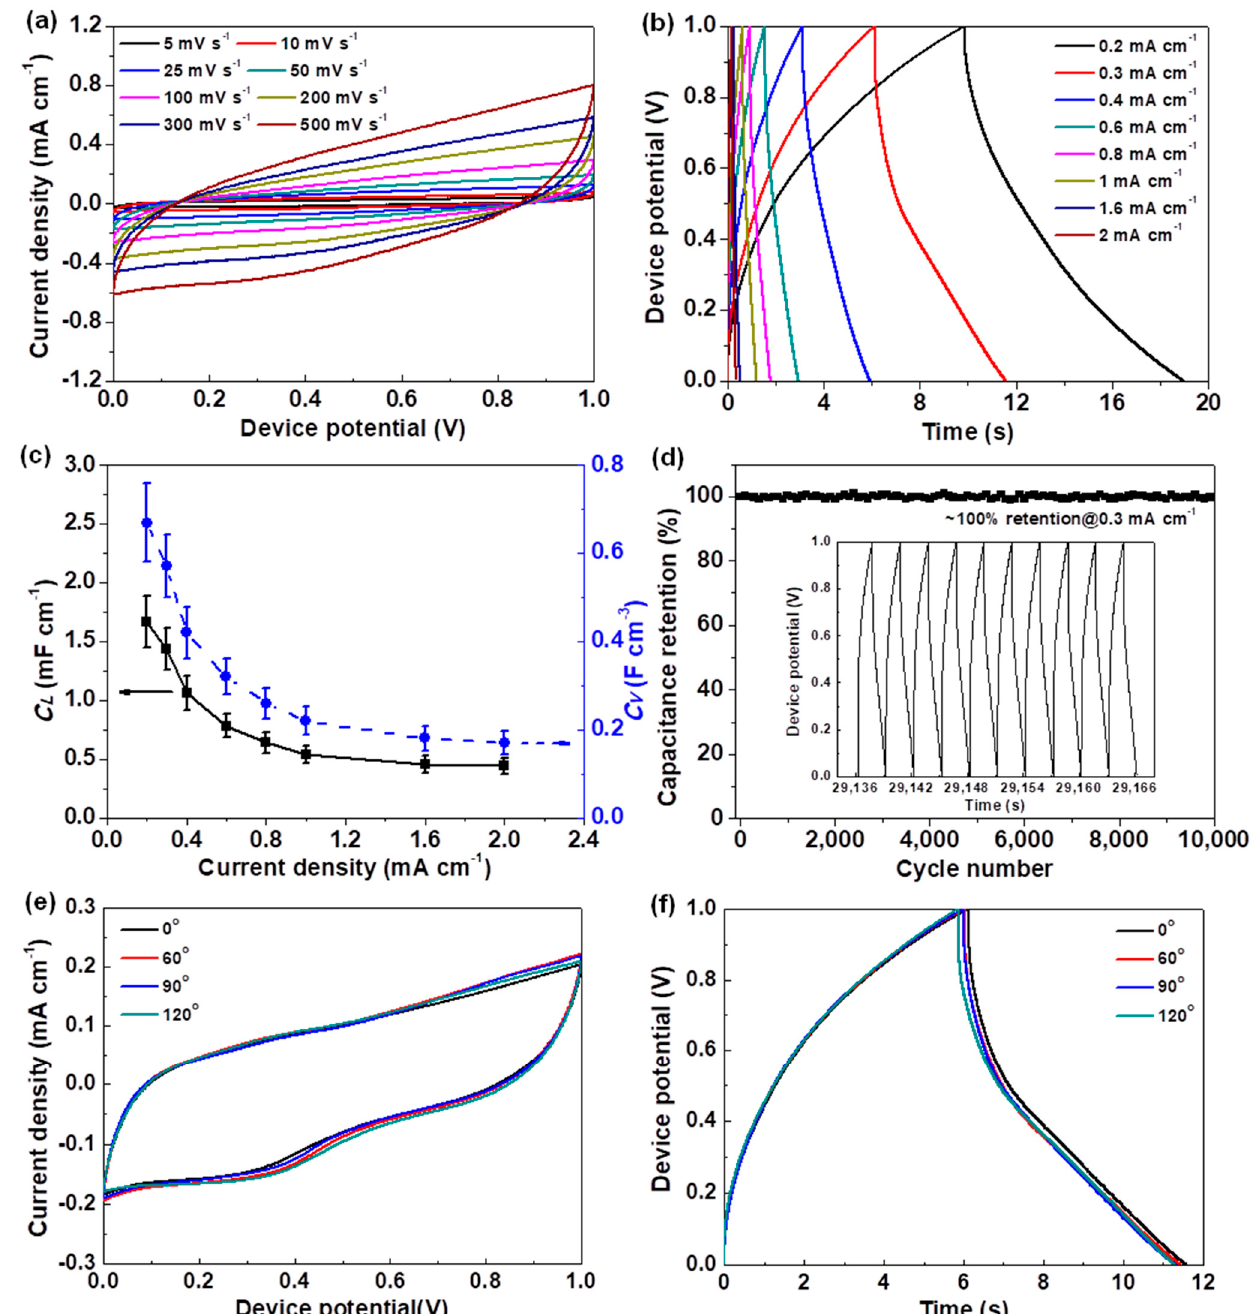
Figure 7. Capacitive properties of the currently developed parallel symmetric FSSC cell (i.e., cotton-RGO-AgNP//cotton-RGO-AgNP). ( a , b ) CV and GCD curves recorded at varied scan rates and current densities, respectively; ( c ) plot of the relationship between specific capacitance and current density; ( d ) cyclic performance of such an FSSC cell; the inset presents the last 10-cycle GCD curve for the cycling durability investigation; ( e , f ) performances of bending tests evaluated by CV measurements at 100 mV·s − 1 and GCD measurements at 0.3 mA·cm − 1 under different bent states, respectively.